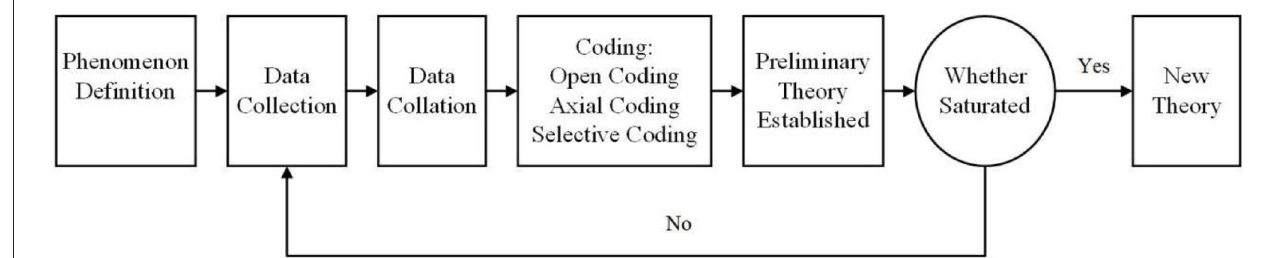
FIGURE 3 | The process of grounded